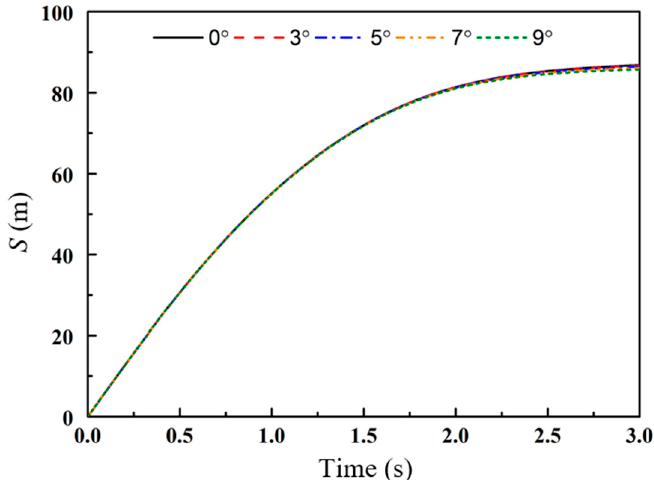
Figure 15. Displacement–time in simulation.